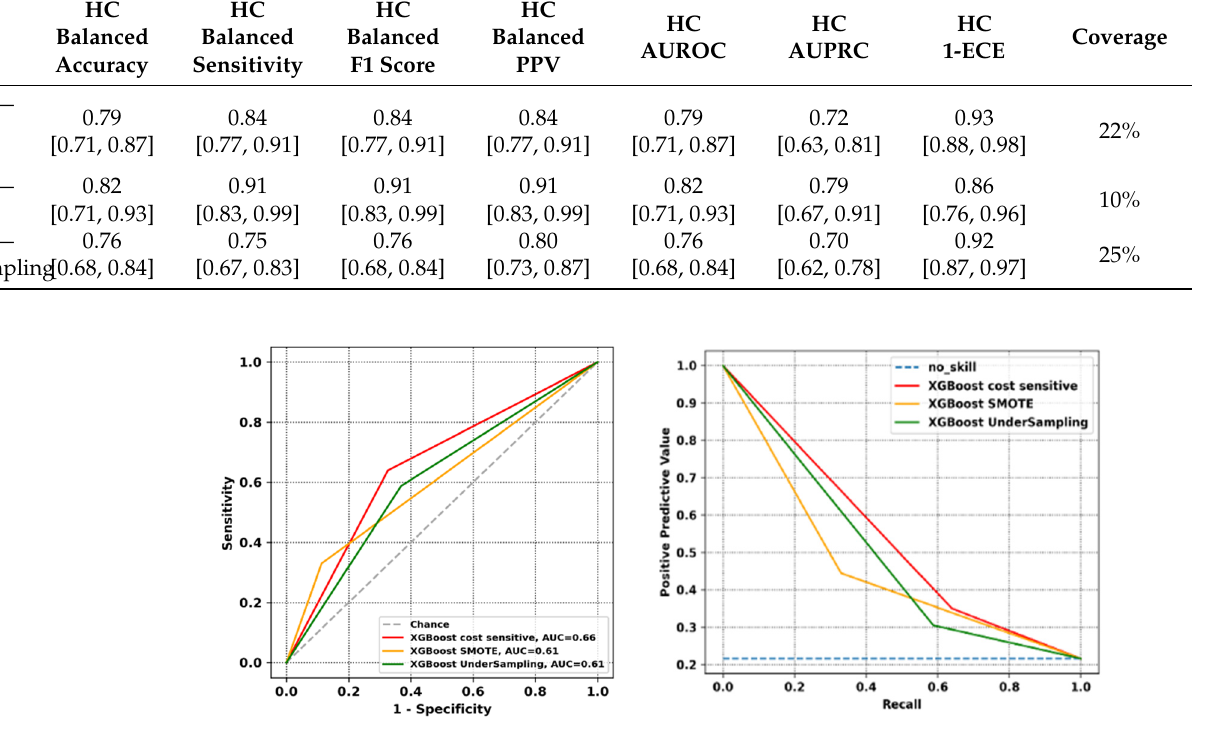
Figure 1. Physical classification task: ROC curve (on the left ) and positive predictive value-recall curve (on the right ) (on test set).